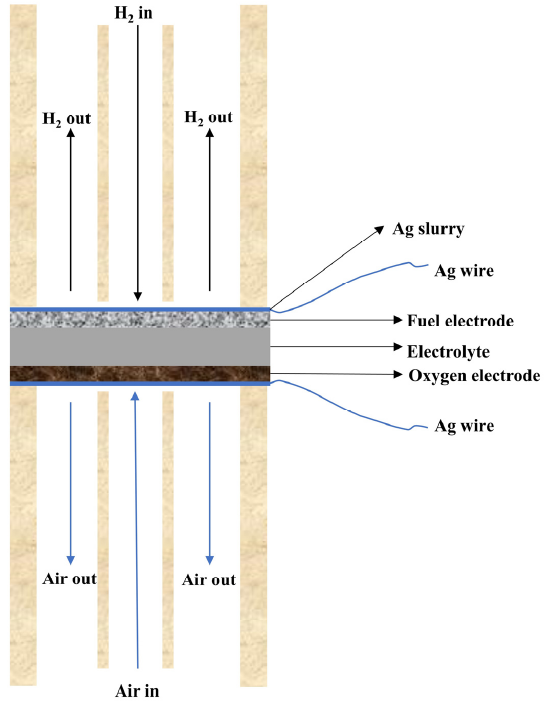
Figure 2. Schematic diagram of single cell testing equipment.